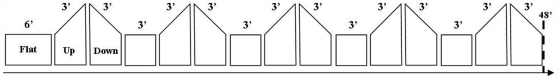
Schematic representation of the simulated running trail.Flat, 0% gradient section; Up, +10% gradient section; Down, −15% gradient section.